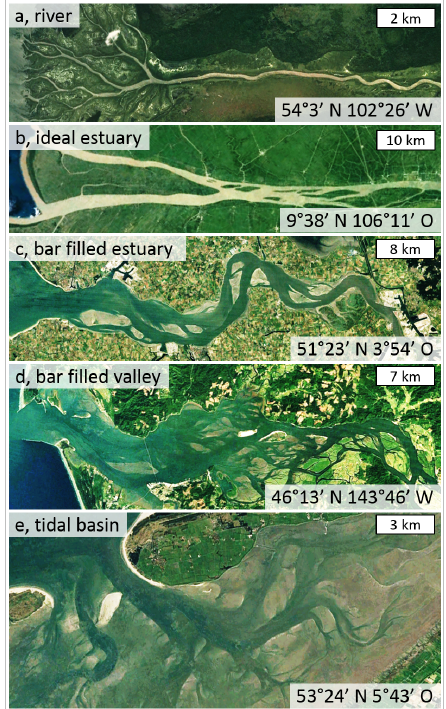
Figure 2. Examples of the systems used in this study. ( a ) a delta branch of a distributary of the Saskatchewan River (Canada); ( b ) the Tran De branch of the Mekong Delta (Vietnam); ( c ) the Western Scheldt estuary (The Netherlands); ( d ) the Columbia River estuary (USA); ( e ) the Ameland inlet and tidal basin (The